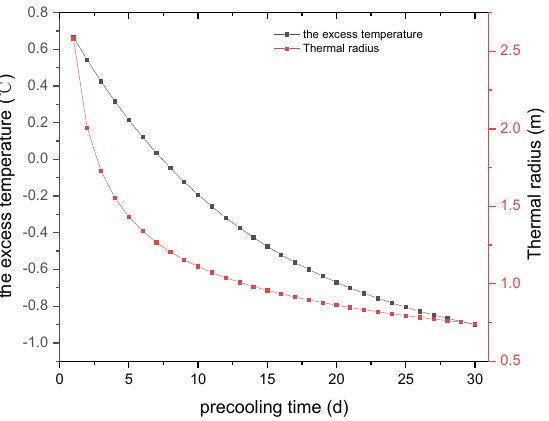
Figure 7. Variation in average soil excess temperature and thermal radius at the end of the 168 h discharging process under different precooling times.